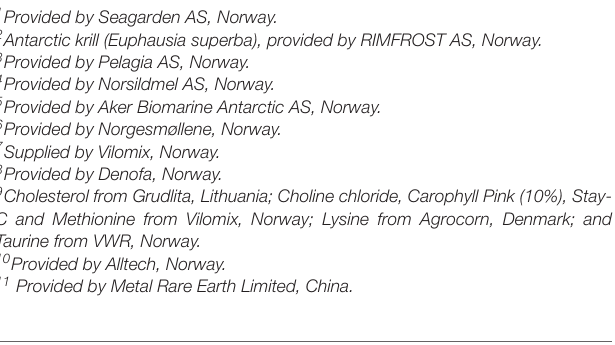
TABLE 2 | Proximate composition (%) of nutrients in experimental diets.